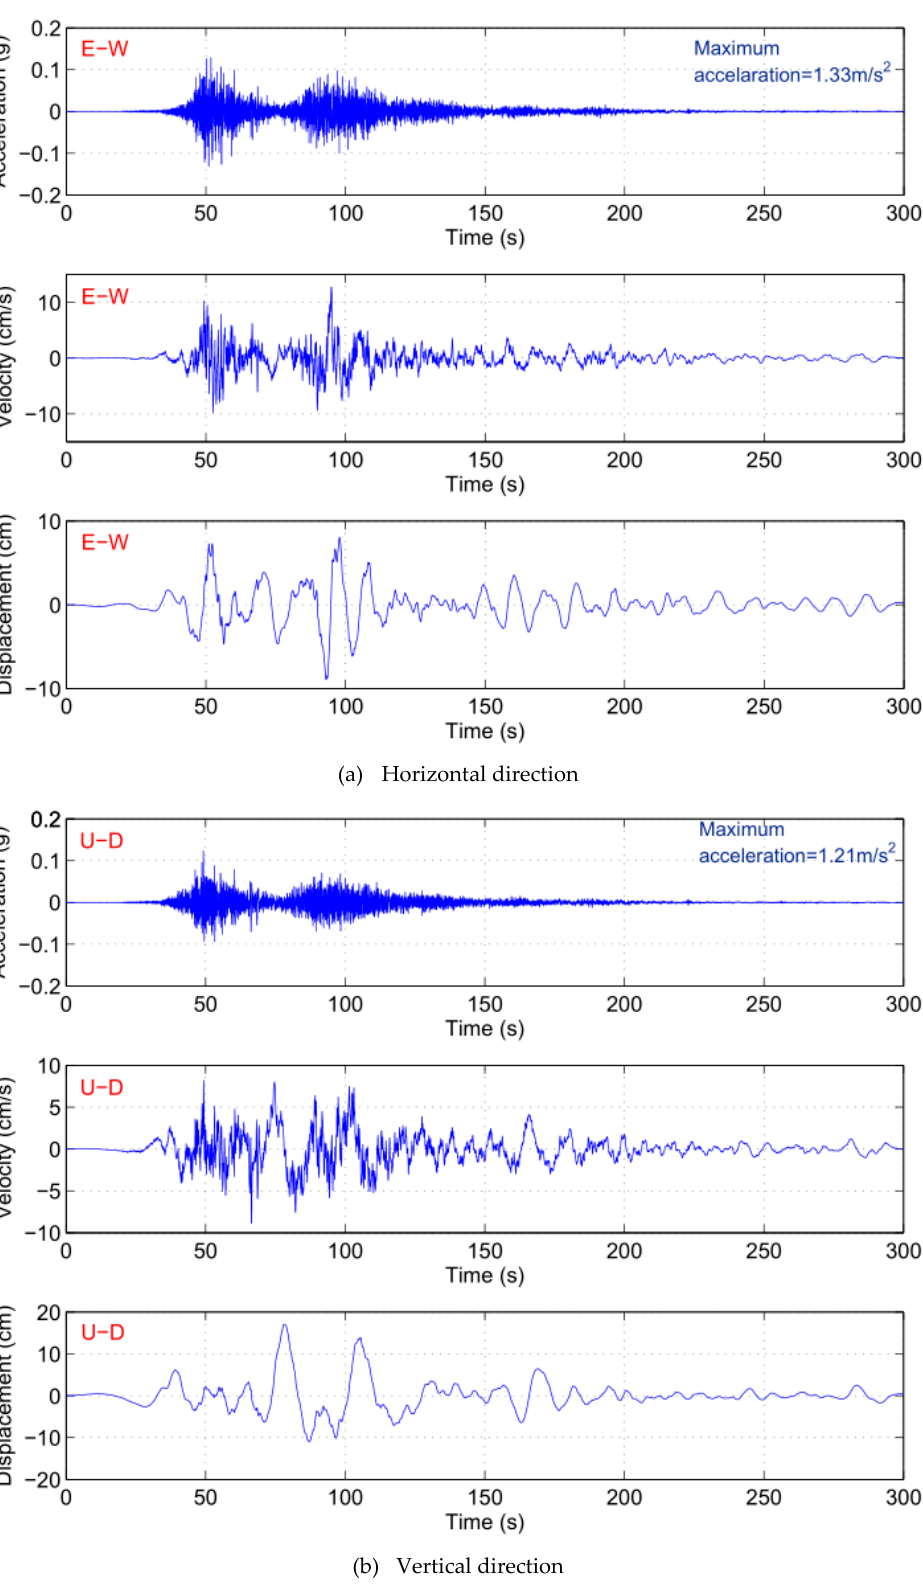
Commented [M1]: Please add explanations for all subfigures in the caption, see example in Layout Template.